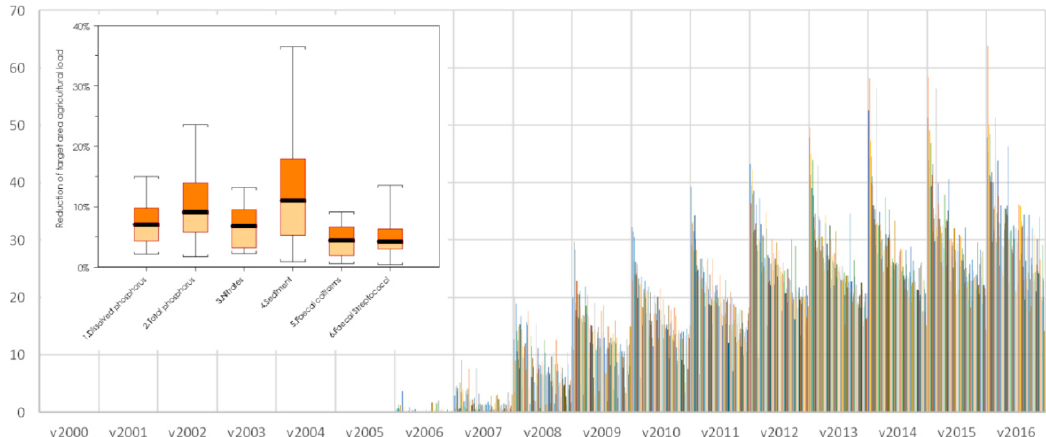
Figure 6. Year-on-year predictions of percentage reduction in suspended solids for targeted catchments compared with 2014 catchment sensitive farming (CSF) predictions (inset, after EA, 2014).